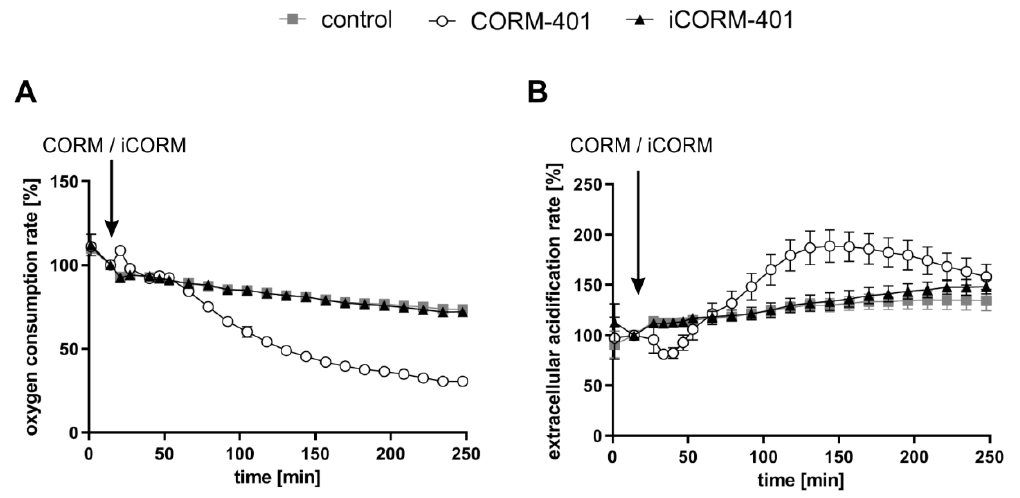
Figure 1. Extracellular flux technology reveals CO-dependent modulation of cellular respiration and extracellular acidification by CORM-401. CORM-401 and iCORM-401 were injected (indicated by arrows) into reaction wells and OCR ( A ) and ECAR ( B ) were measured over time. Final concentration of compounds: 50 µ M. Three independent experiments were performed (n = 3). Representative OCR and ECAR curves are shown. Data represent mean ± SD of at least six technical replicates. OCR = oxygen consumption rate, ECAR = extracellular acidification rate.